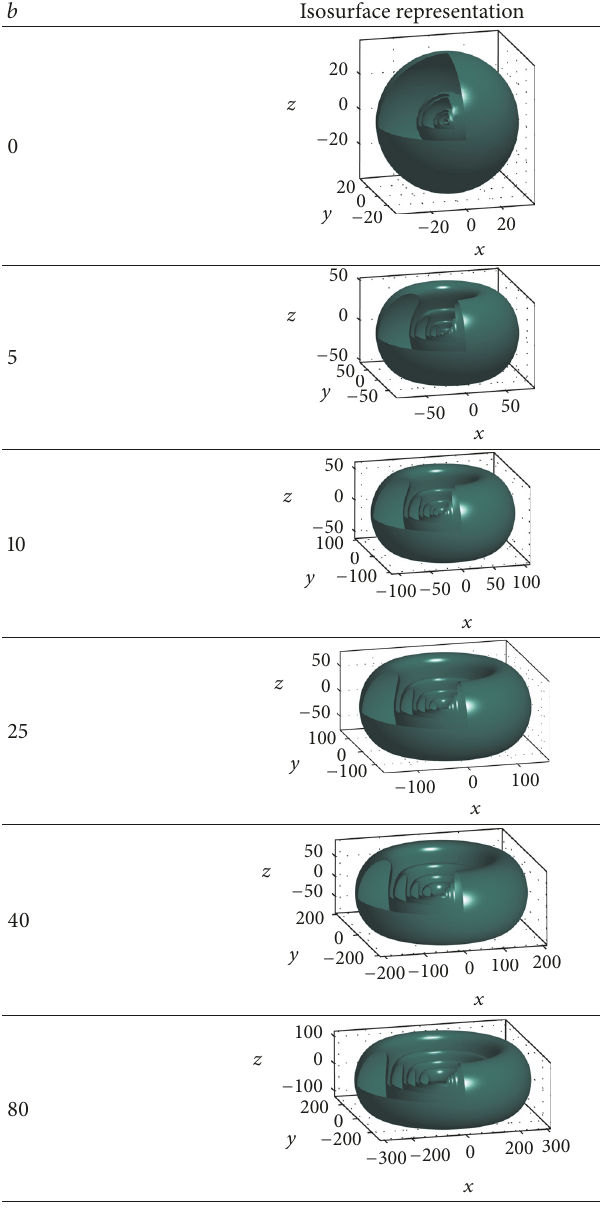
Figure 1: Relation between 𝑛 𝜃 and |𝑎 𝑛